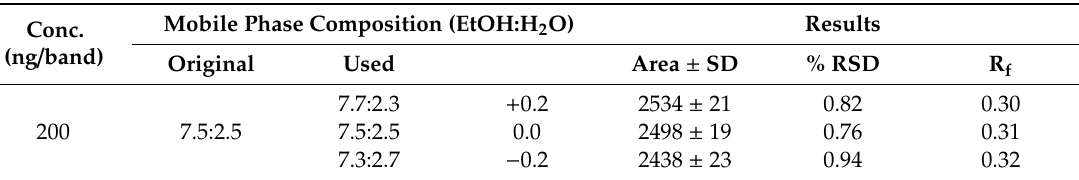
Table 4. The robustness of a green RP-HPTLC method (mean ± SD; n = 6). Conc.